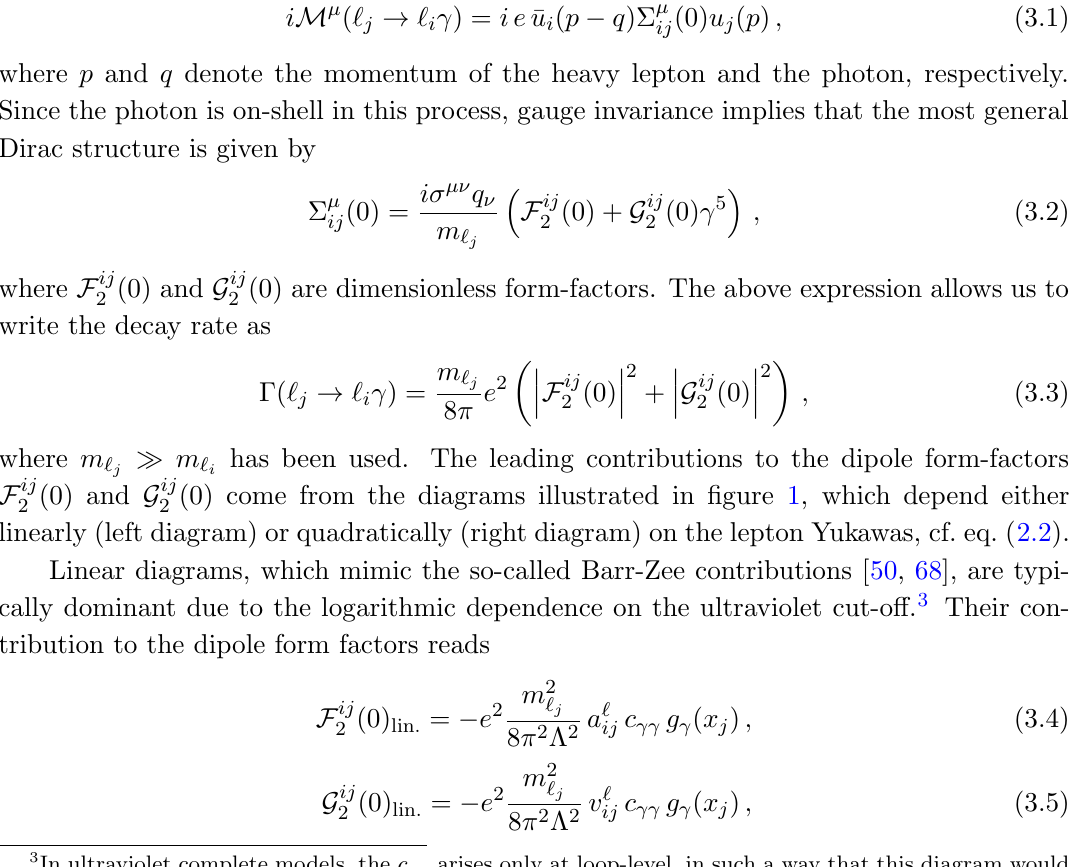
Figure 1 . Diagrams illustrating the ALP contributions to ‘ j quadratic (right panel) order in the Yukawa